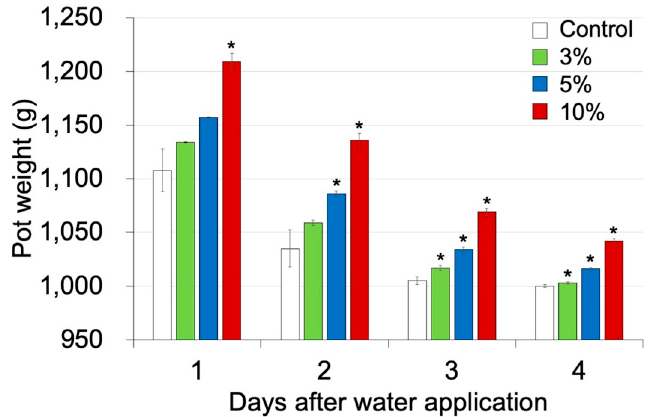
Figure 7. Effect of jatropha fallen leaf biochar application on the moisture contents of the experimental soils. The pot weights were measured daily to estimate the rates of water loss from the potted soils. Values are means ± standard deviations ( n = 3 pots per biochar concentration). Asterisks indicate significant differences from the control ( t -test, p < 0.05).